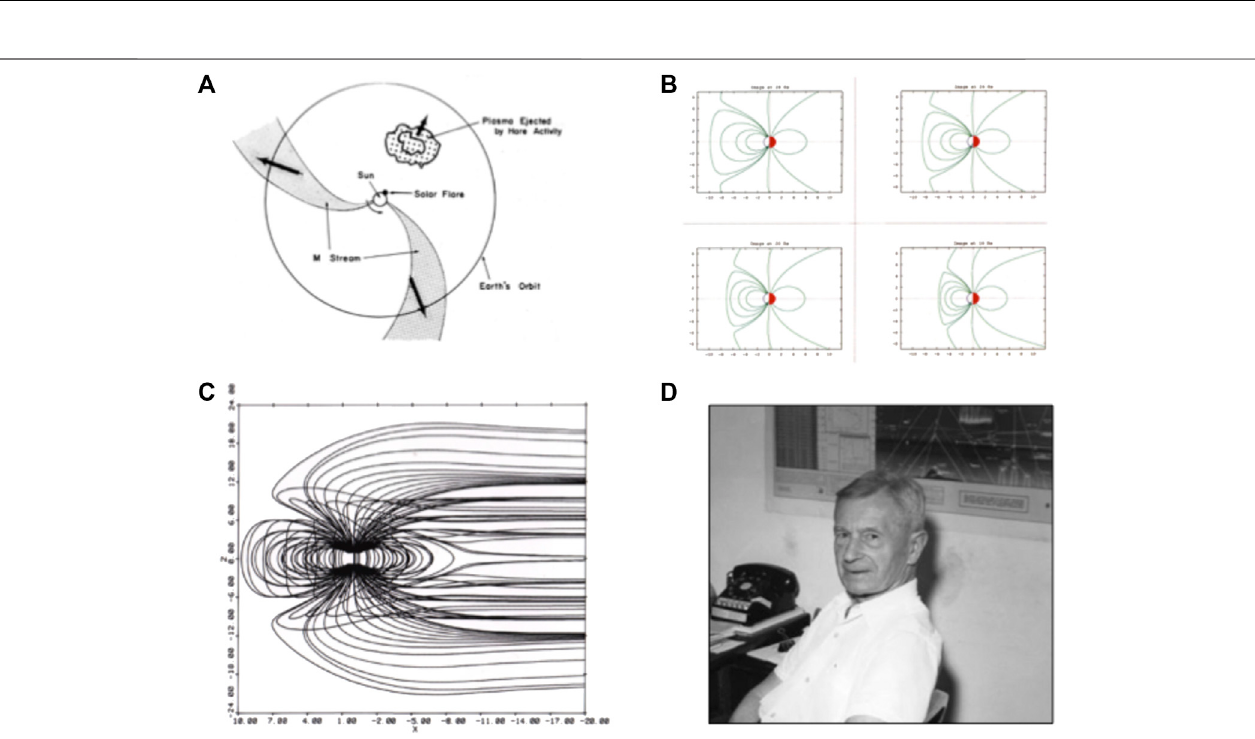
FIGURE3|(A) Thegeneralviewofinterplanetaryspaceuntilabout 1958. (B) Thecompressed Earth ’ sdipolebyaplasma fl owfrom theSun. (C) Thecompression of the front of the magnetosphere by an enhanced solar wind. (D) S. Chapman. Courtesy of the Geophysical Institute of the University of Alaska